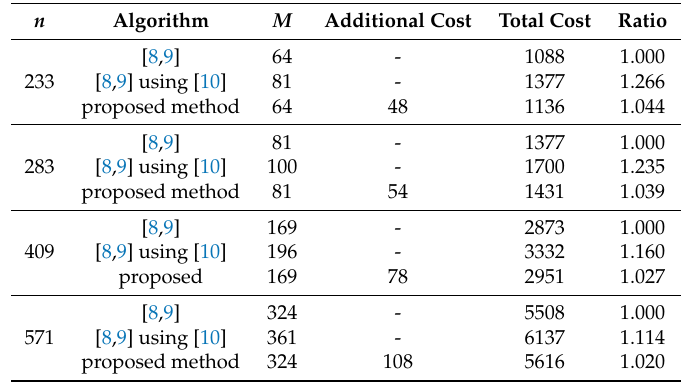
Table 4. The computational cost of the algorithms of the binary Huff